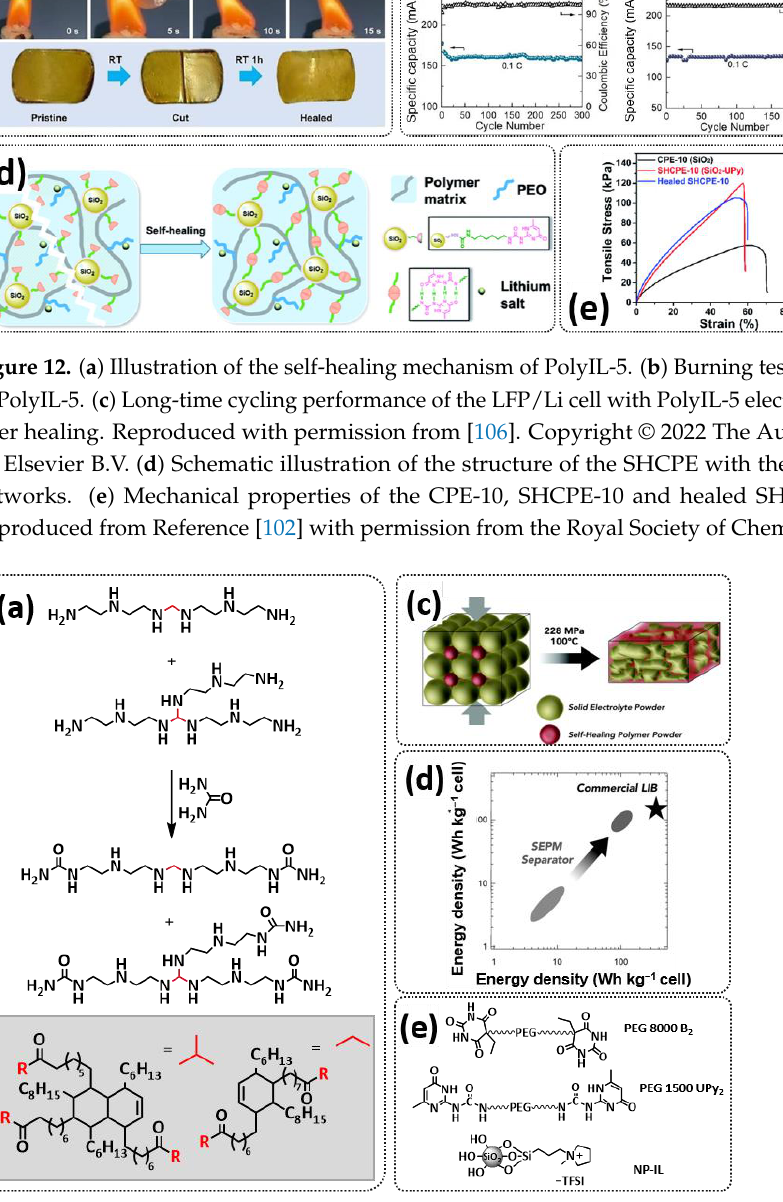
Figure 13. ( a ) Synthesis route of fatty acid-based SHP. ( b ) SEM images of the CPE surface showing the self-healing functionality after 1 h. Scale bar: 100 µm. Reproduced from Reference [101]. ( c ) Schematic for forming the solid electrolyte in polymer matrix membrane (SEPM). ( d ) Enhancement of the gravimetric and volumetric energy densities by moving to an SEPM configuration. Reproduced with permission from [103]. Copyright © 2015 WILEY-VCH Verlag GmbH & Co. KGaA, Weinheim. ( e ) Chemical structures of the materials used for the preparation of 3D-printable CPEs. ( f ) Printed CPE. Reproduced from Reference [105]. 4. Self-Healing Binders for Lithium Batteries Although graphite carbon holds the main market of anodic materials in commercial LIBs due to the fact of its cycling stability, the low theoretical capacity (372 mAh g −1 , LiC 6 ) hinders its further development and applications in high-energy LIBs [5]. One of the promising next-generation anode materials for lithium batteries is lithium metal (LM) because of its high theoretical specific capacity (3860 mAh g −1 ) [128 – 132]. However, the safety issue and the uncontrollable Li dendrite growth are still difficult to overcome [18,133,134]. Another promising anode material for next-generation high-energy density LIBs is the intercalation-type silicon (Si) anode, which offers the highest known theoretical specific capacity, approximately ten times higher than that of conventional graphite anodes (4200 mAh g −1 , Li 4.4 Si), accommodating over four Li + per Si [132,135,136]. However, its practical application is seriously impeded by its mechanical and electrochemical instability. Thus, the introduction of self-healing polymeric materials in order to increase the electrochemical capacity and durability of electrode materials is of great importance for next-generation lithium batteries. The progress in self-healing polymer binders for Si- and Li-metal anodes is summarized in Table 2 for comparison and discussed in detail in the following sections.